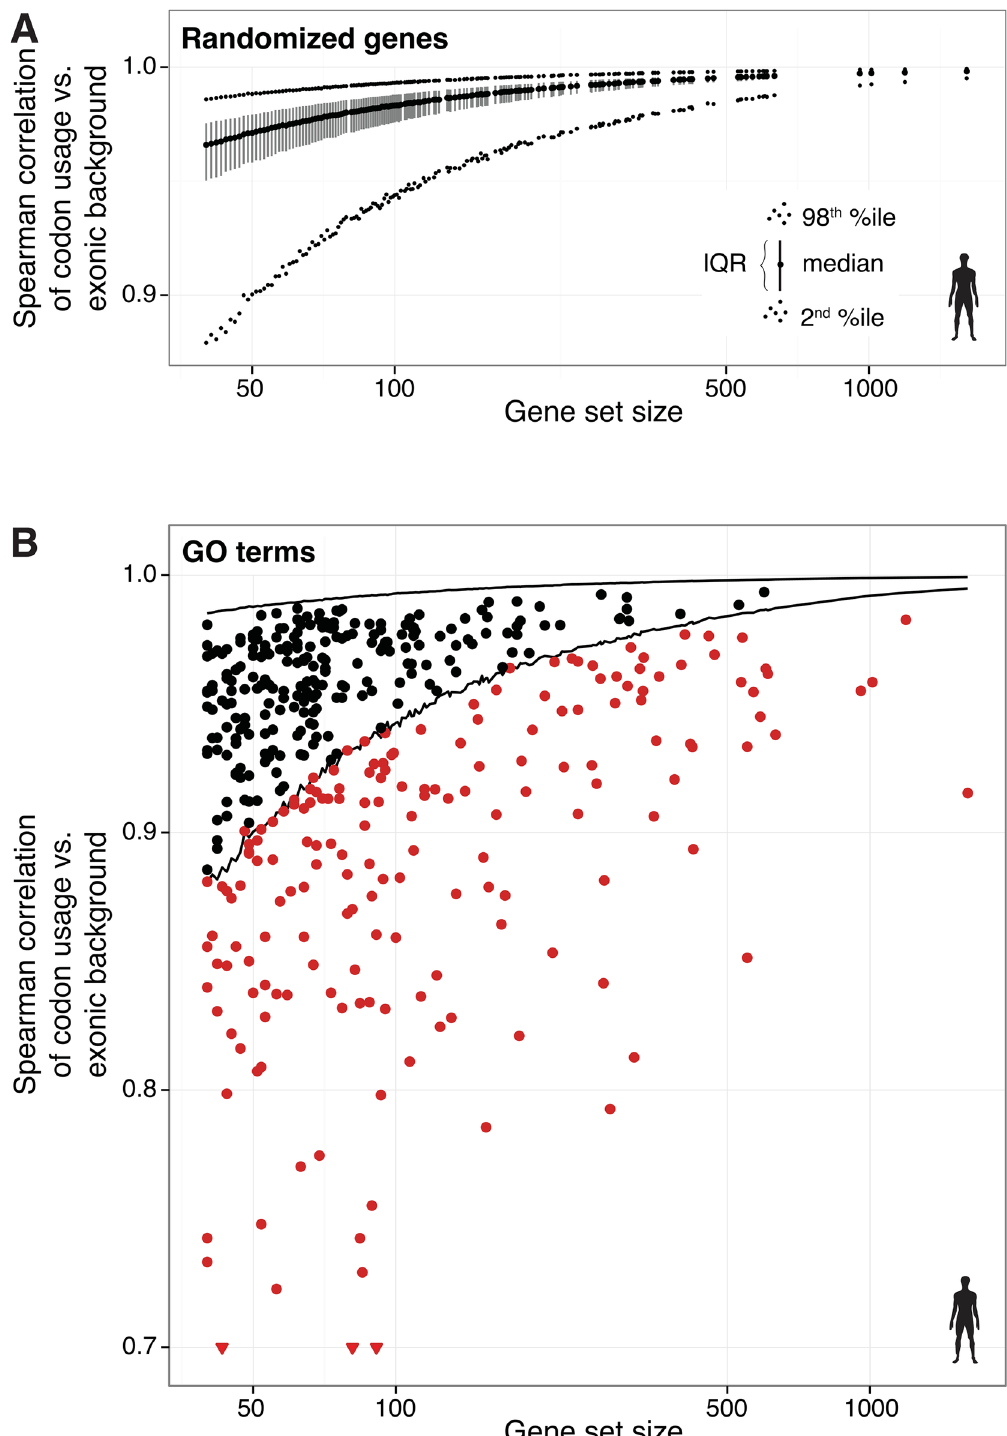
Fig 1. Gene set sample size correlates with codon usage variability. ( A ) Genes were randomly sampled from the human genome to create sets of different sizes corresponding to GO term set sizes (x-axis). The codon usage of each set was calculated and correlated with the exonic background (Spearman ’ s rank correlation coefficients ( ρ ); y- axis). For each set size, the distribution of 10 000 repeated samples is summarized in the figure by a vertical segment connecting the 1 st with the 3 rd quartile (interquartile range, IQR); the median is indicated as a black dot;